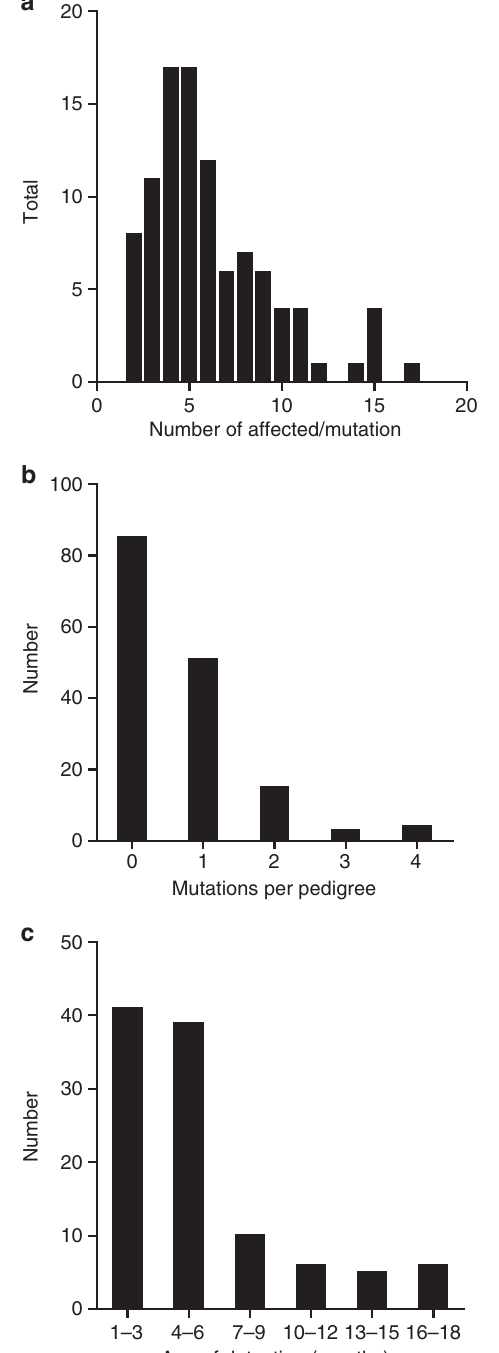
Figure 1 | Summary statistics for mutation discovery in the Harwell ageing Screen. ( a ) The distribution of the numbers of affected mice observed for each mutation within the G 3 pedigrees. For lines with low numbers of affected mice, putative mutations were confirmed by inheritance testing and/or cloning of the underlying mutation. ( b ) The distribution of the number of mutations identified per pedigree from a total of 105 mutant lines identified from a total of 157 pedigrees. ( c ) The distribution of mutation discovery over time. The time point of the initial identification of an individual phenotype is represented here for a total of 105 mutant lines identified in the screen to date. Where mutants were outliers in more than one phenotypic test the time point of the first test to reveal an abnormality is